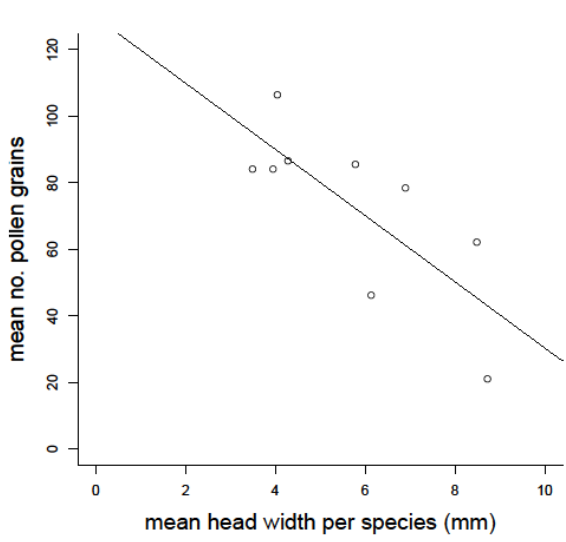
F IGURE 6. The relationship between the mean number of pollen grains deposited on stigmas and the head width (in mm) of the species visiting a flower. N = 9 bee